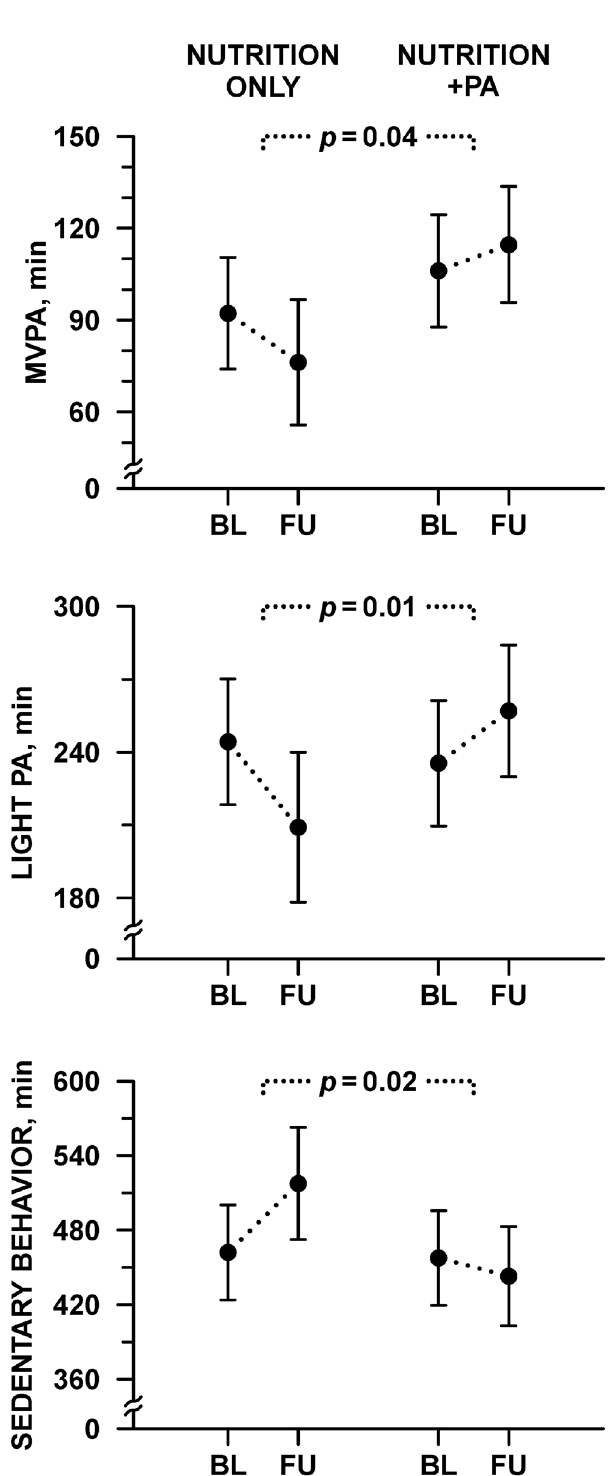
Fig 2. Physical activity and sedentary behavior as measured by accelerometry. Adjusted means with 95% confidence interval at baseline (BL) and follow-up (FU), compared between nutrition+PA and nutrition only. Vertical axes with suppressed zero are employed to highlight